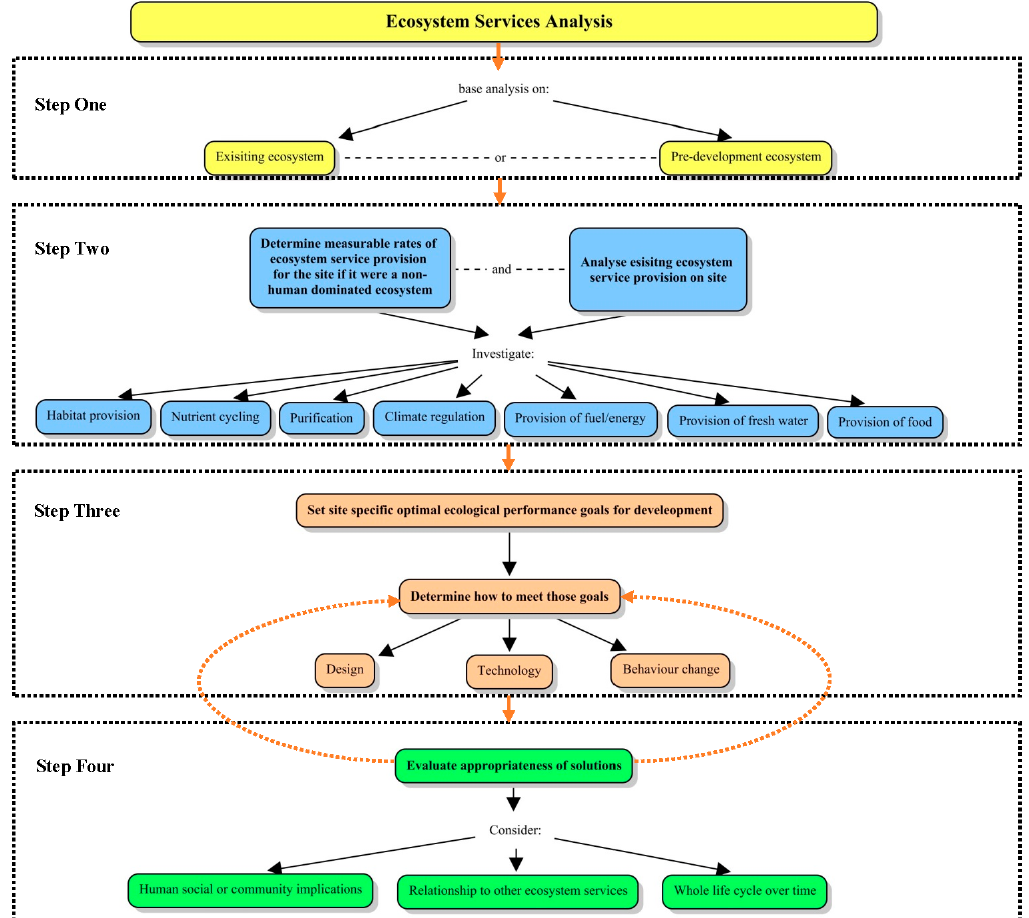
Figure 1. Ecosystem Services Analysis Process (adapted from: [28]).